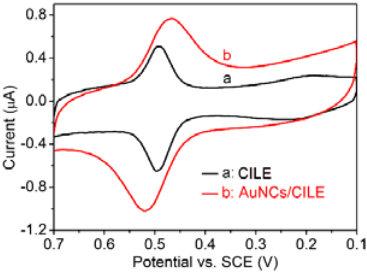
Figure 3. Cyclic voltammograms of 1.0 μ M luteolin on CILE (a) and AuNCs/CILE (b) in 0.1 M PBS (pH = 3) at a scan rate of 100 mV/s.